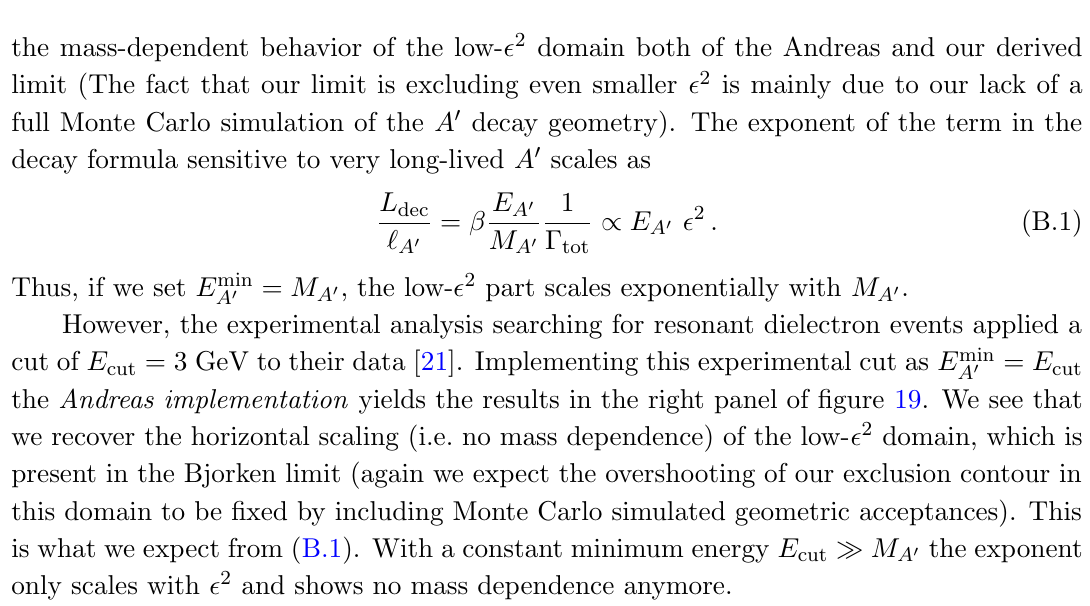
Figure 19 . Expected number of events N for a secluded hidden photon A 0 at the SLAC E137 experiment obtained from the Andreas implementation as a function of the mixing parameter (cid:15) 2 and the mass M A 0 normalized to the 95% C.L. limit N 95 . The red (Bjorken) and cyan (Andreas) lines show the exclusion contours calculated in [27] and in [33], respectively. Left: including the full A 0 width, in particular also the partial width into muons. Right: only including the partial width of the A 0 into electrons and including the extra factor of